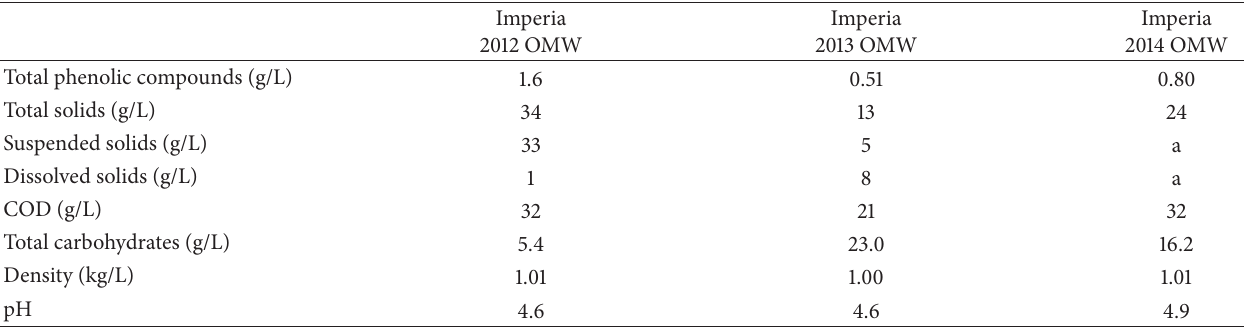
Table 1: Main characteristics of the tested OMWs.